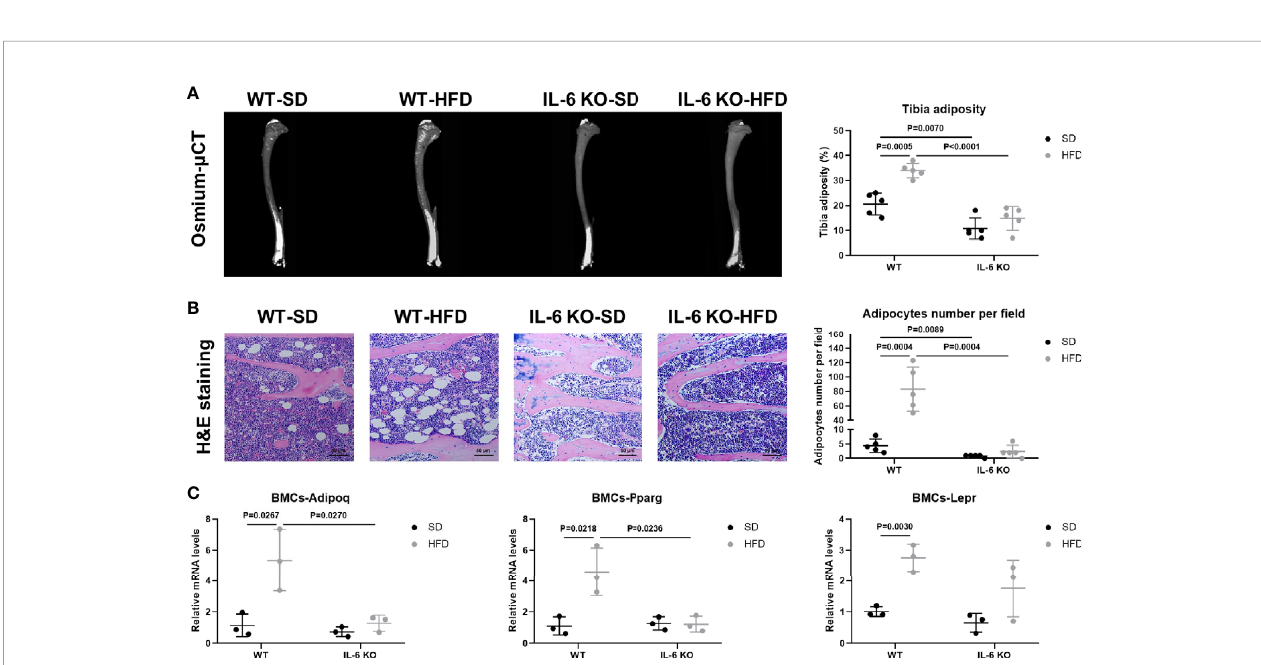
FIGURE 4 | IL-6 KO attenuated adipogenesis of BM in HFD-induced obesity. (A) Representative images of BMAT from full-length tibial sagittal plane of WT and IL-6 KO mice fed with SD or HFD by m CT. Quanti fi cation of the osmium density in tibial sagittal plane was expressed as tibia adiposity (right panel). (B) Histopathological analysis on bone sections from tibia stained with H&E staining from WT and IL-6 KO mice after SD or HFD treatment (scale bar = 50 m m). Adipocyte number per fi eld on H&E section was evaluated by Image J software (right panel). (C) The mRNA levels of adipogenic genes in bone marrow cells (BMCs) of WT and IL-6 KO mice after SD or HFD. Data were expressed as mean ±